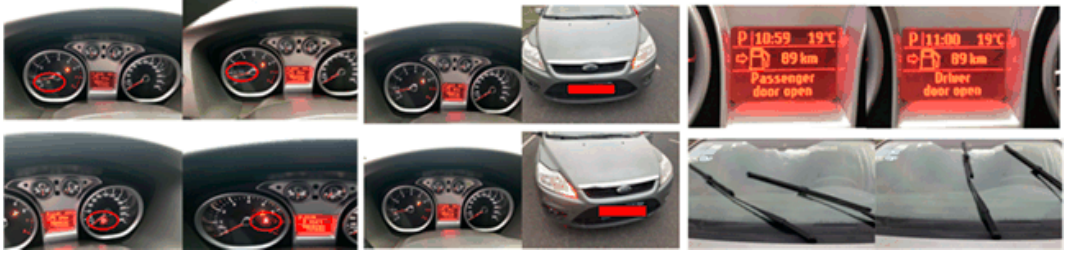
Figure 5. Replay attack against the Ford vehicle.